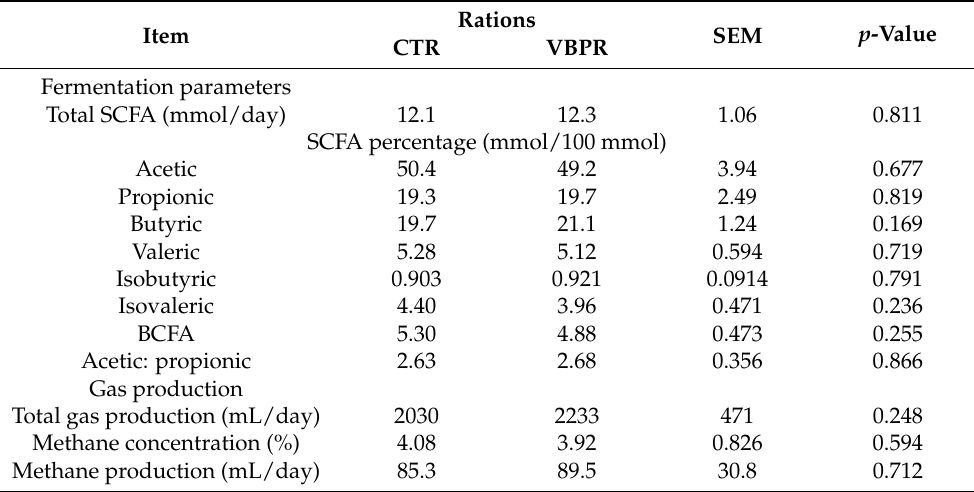
Table 7. Rumen fermentation parameters and gas production of the experimental